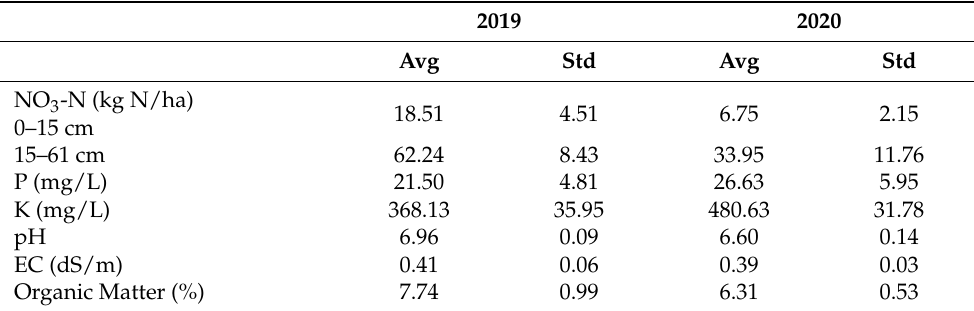
Table 1. Soil nutrient analysis at the experimental site, while Avg means average value at eight locations, and Std means standard deviation of values at eight locations.